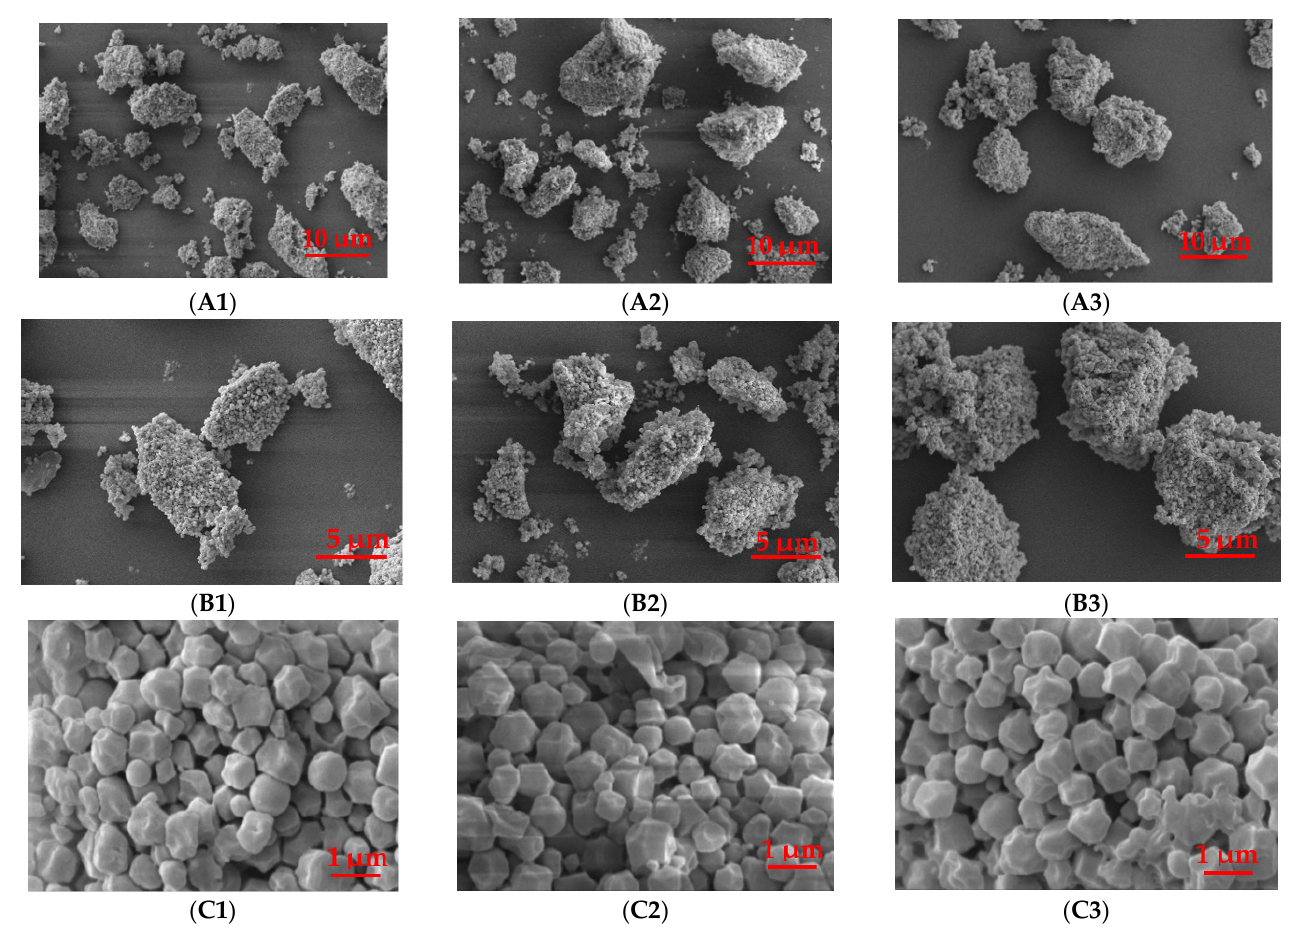
Figure 1. SEM images of quinoa starch isolated by alkali ( A1 – C1 ), wet-milling ( A2 – C2 ), and enzymatic ( A3 – C3 ) methods at 500×, 1000×, and 10000× magnifications.